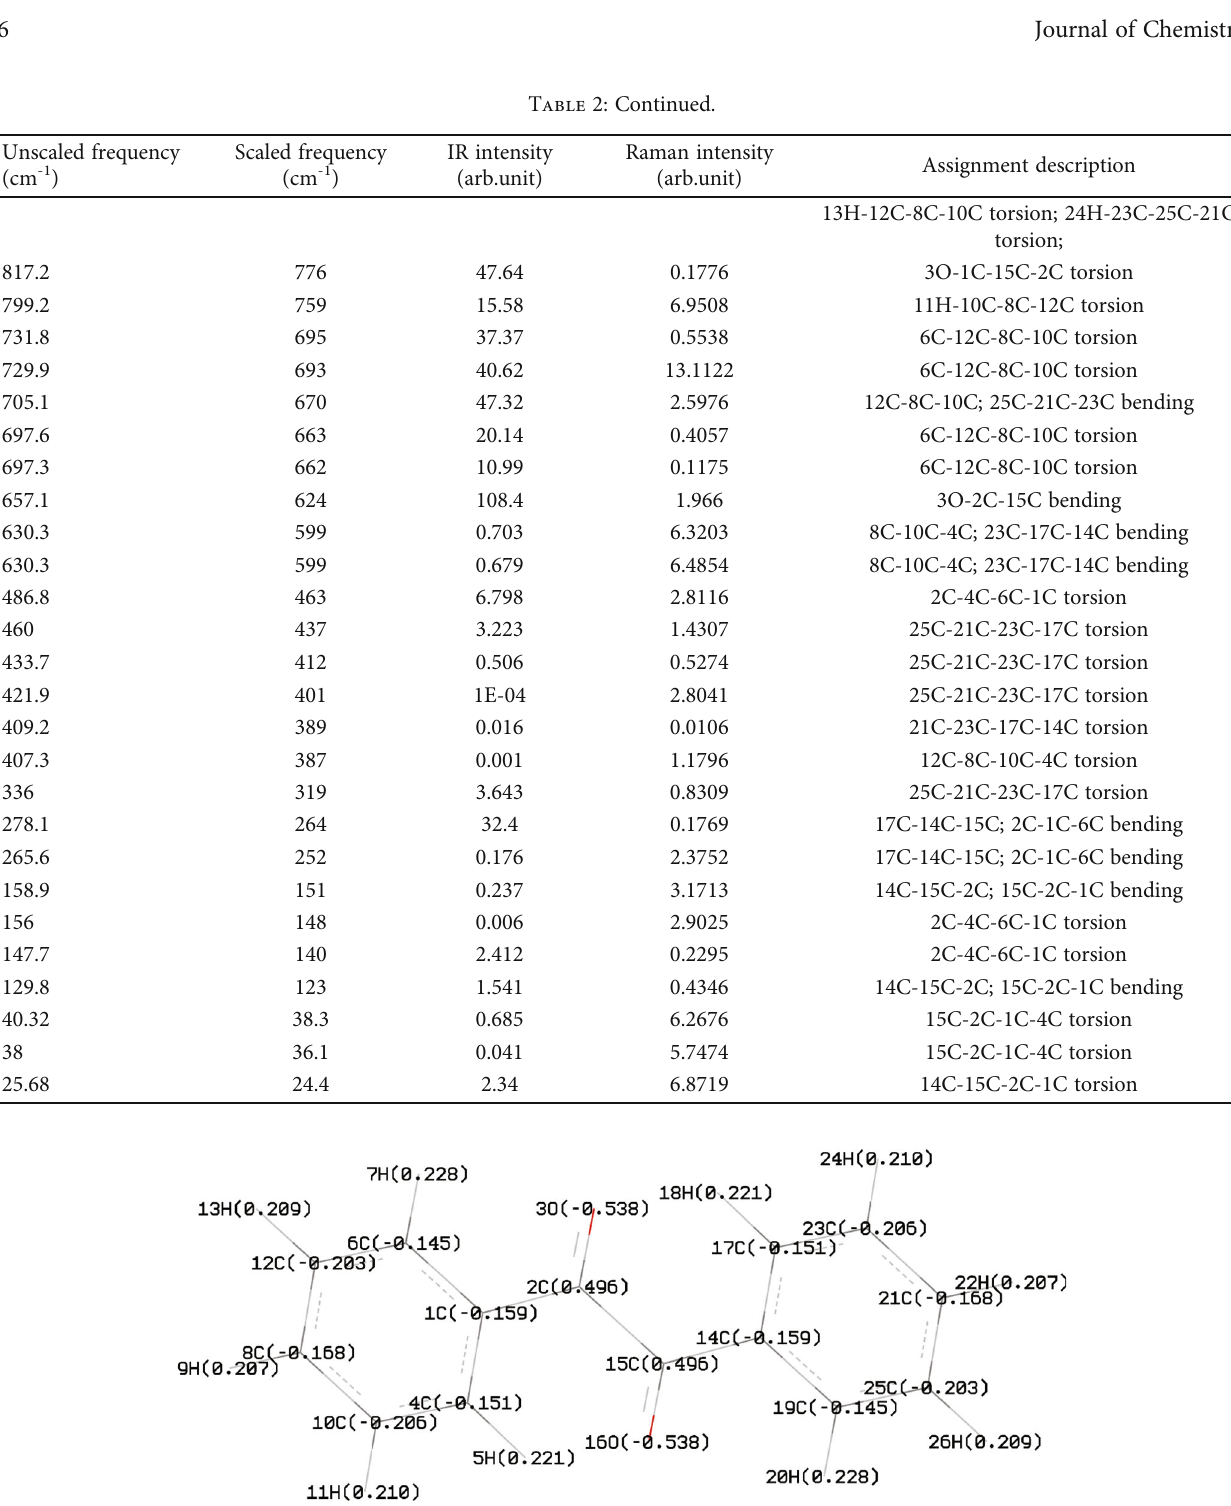
Figure 4: NBO charges of